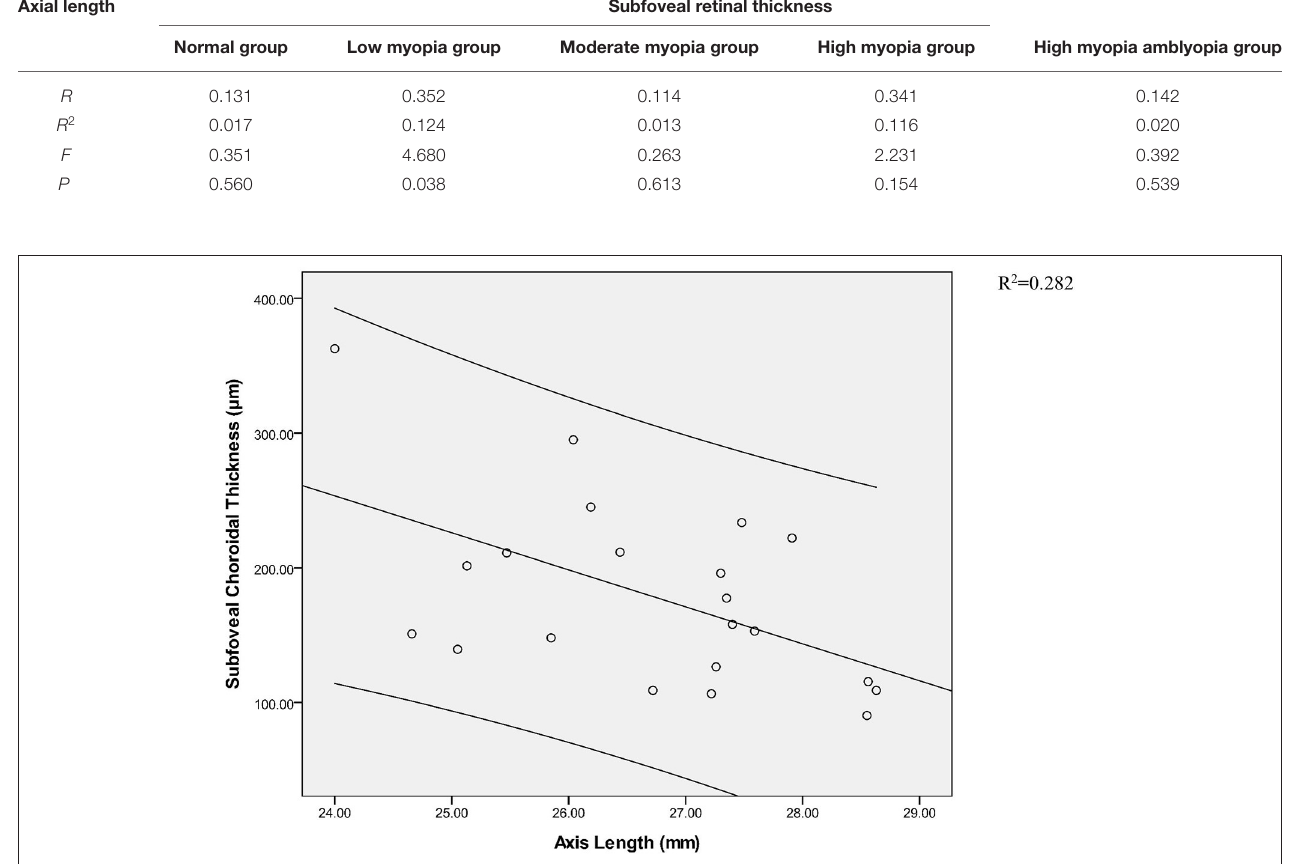
FIGURE 3 | Pearson correlation analysis of subfoveal choroidal thickness and axial axis in high myopic amblyopic eyes.